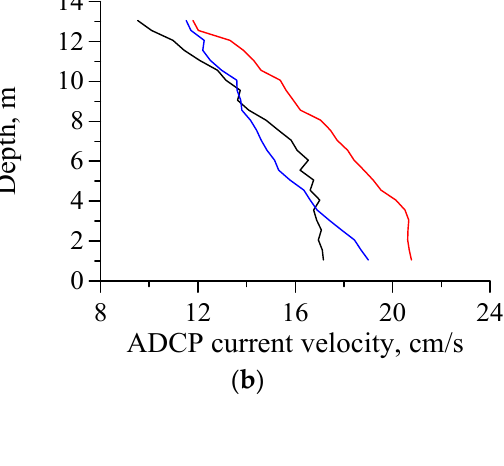
Figure 1. ( a ) MC vs. incidence angle (PD). Black curves are S-band, red—C-band, blue—X-band, dashed curves are 10 m/s, solid curves are 5 m/s. ( b ) MC vs. wind speed. Black curves are S-band, red are C-band, and blue are X-band. Incidence angle is 60 degrees.